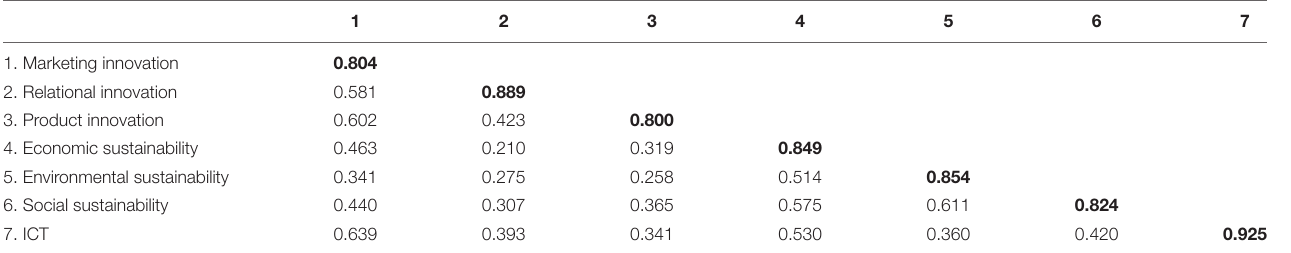
TABLE 3 | Measurement instrument: Discriminant validity (Fornell-Larcker criterion). 1